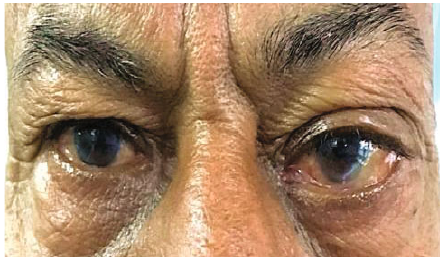
Figure 1: Clinical photograph showing left superior orbital fullness displacing the eyeball inferomedially.